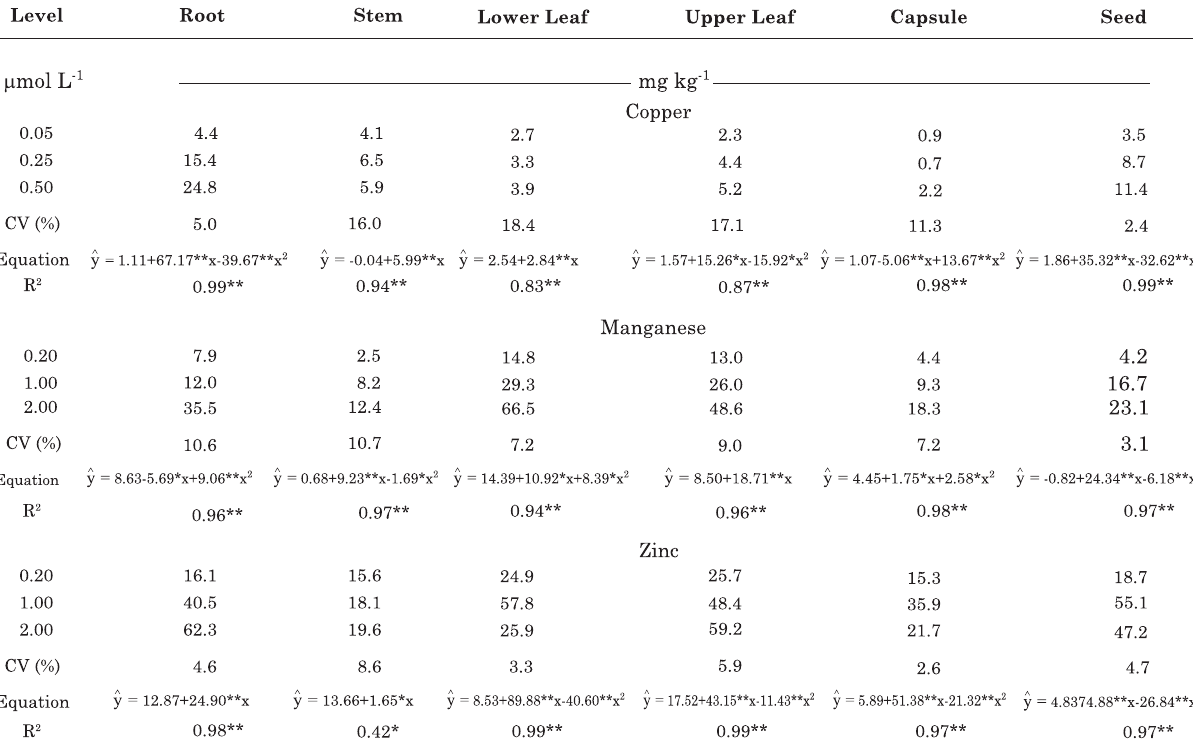
table 2. cupper, mn and Zn concentration (y) in parts of the castor bean hybrid “iris”, grown in a com- plete nutrient solution and with different levels of cu, mn and Zn